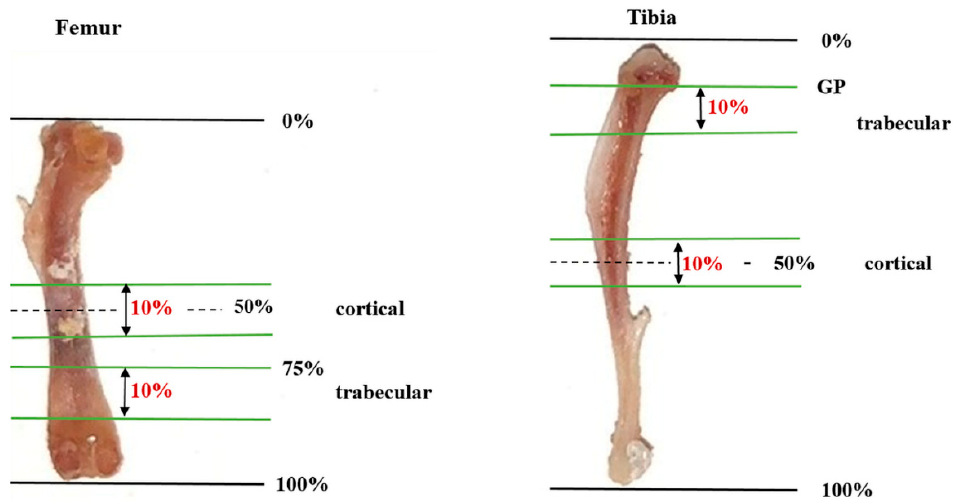
Figure 3. Schematic representation of the micro-CT scanning procedures for the assessment of bone microstructure at the distal femur and proximal tibia. The total bone length is displayed as 100%—proximal stated as 0%, distal bone as 100%. GP: growth